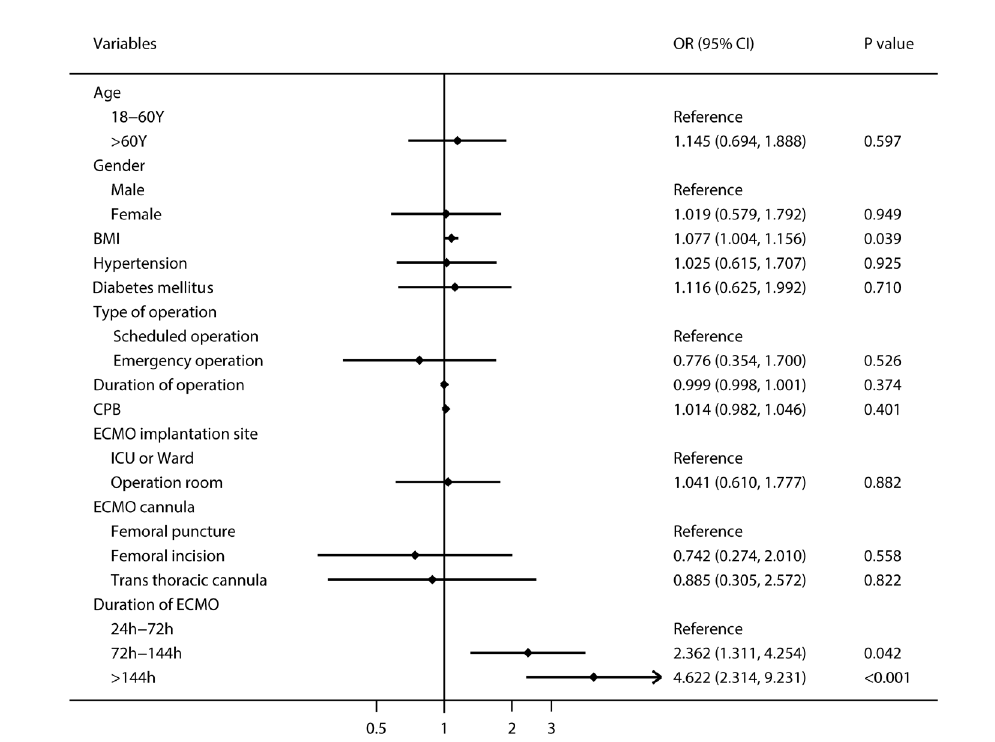
Fig. 3 - The multivariate logistic regression analysis of risk factors for extracorporeal membrane oxygenation (ECMO)-related nosocomial infection. BMI=body mass index; CI=confidence interval; CPB=cardiopulmonary bypass; ICU=intensive care unit; OR=odds ratio